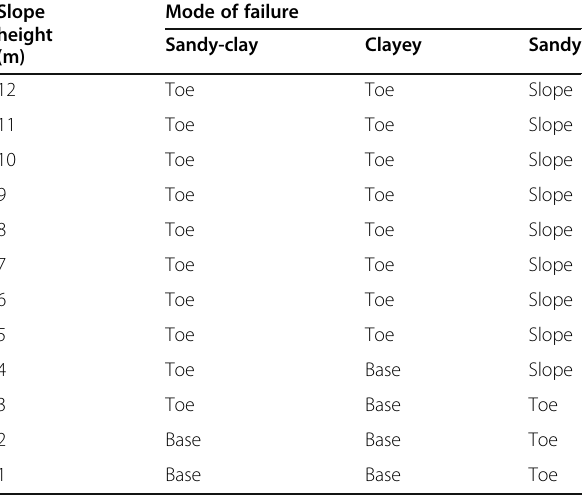
Table 3 mode of failure based on